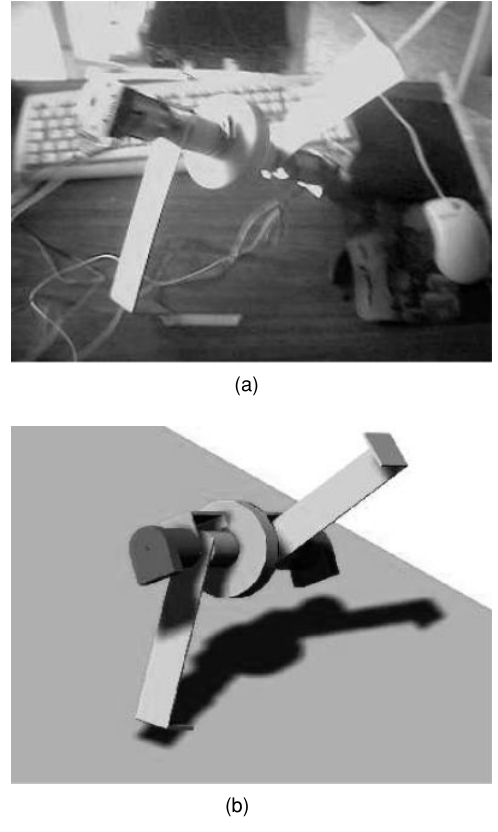
Figure 5 Real-time and CAE simulator results: Notice the very well-matched results. The CAE simulator uses the real parameters obtained through the use of real constraints and the quantisation of the real system. (a) Instability due to torsional torques along the (cid:2) z axis. (b) The CAE simulator reproduces the above fall, thanks to implementation of the mechatronics